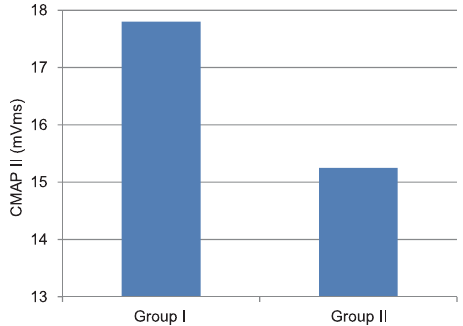
FIGURE 6. Compound muscle action potential areas (after distal stimulation). Median value CMAP-II areas Group I was 17.80 mVms, and Group II 15.25 mVms. Differences were statistically signi fi cant (p =